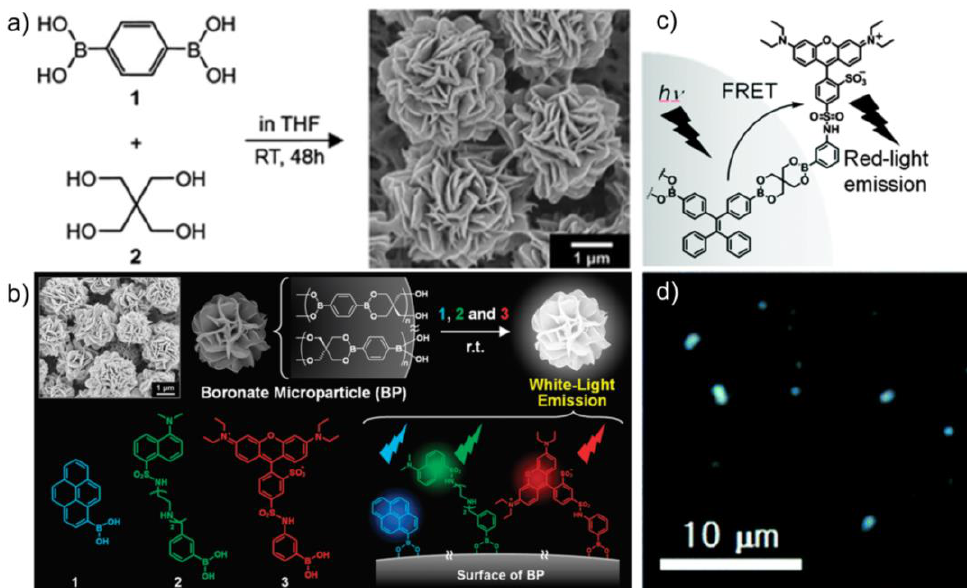
Figure 5. ( a ) The formation of flower like assembly in Ref. [59]. Reproduced with permission from Ref. [59]. Copyright 2012, Royal Society of Chemistry. ( b ) Preparation of white-light emitting boronate assembly. Reproduced with permission from Ref. [60]. Copyright 2013, Royal Society of Chemistry. ( c ) A plausible partial structure where fluorescence resonance energy transfer occurs in tetraphenylethylene and rhodamine B-based assembly. ( d ) The fluorescence microscopic image of white-light emissive assembly in Ref. [61]. Reproduced with permission from Ref. [61]. Copyright 2015, Royal Society of Chemistry.